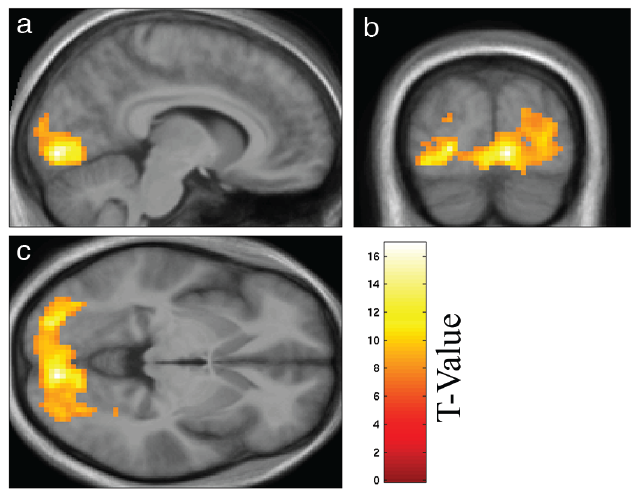
Fig 1. Activation during the block-design fMRI localizer. Region of interest as defined by the block-design with a height threshold of p < 0.05 (FWE corrected) displayed on sagittal (a), coronal (b), and transversal (c) slices of the mean normalized brain of the study